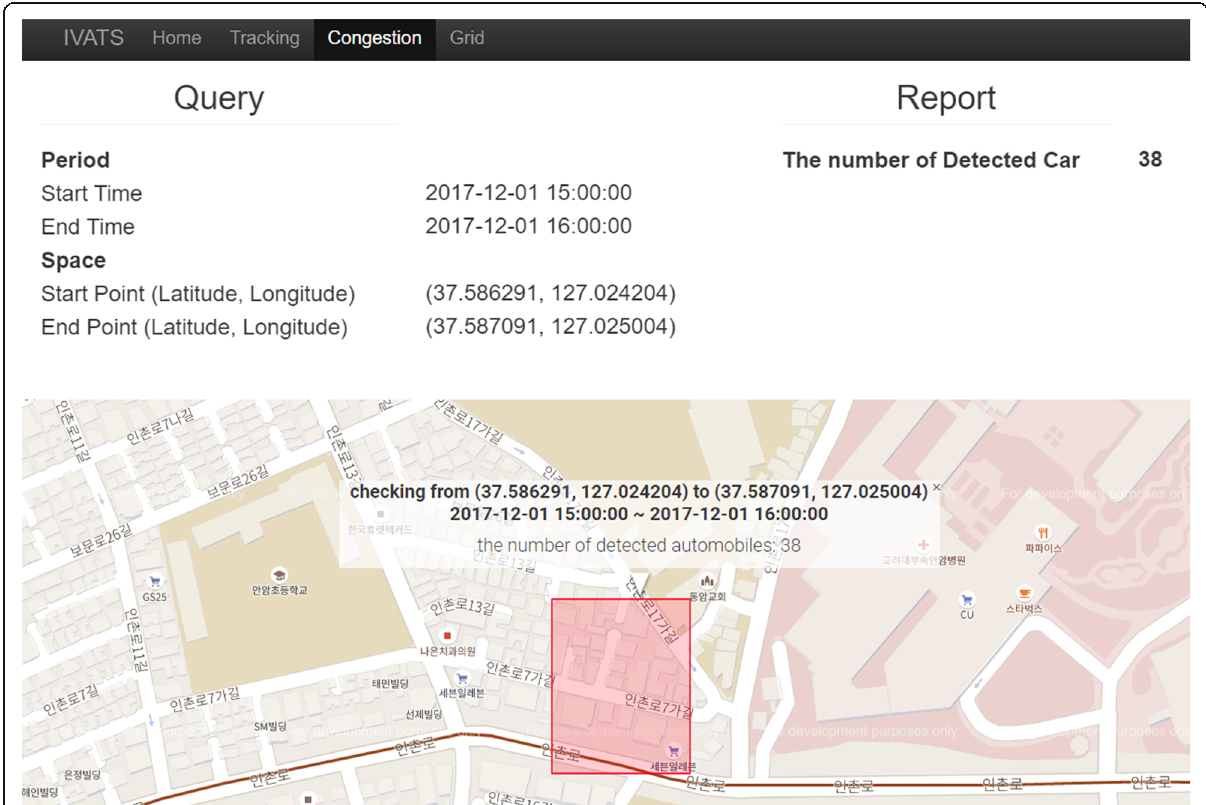
Fig. 8 An example of traffic evaluation in a specific